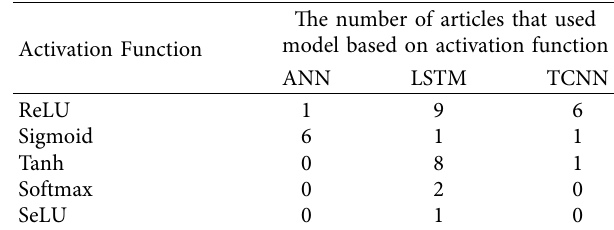
Figure 6: Application according to models used. Table 10: Activation function used in each model in the reviewed